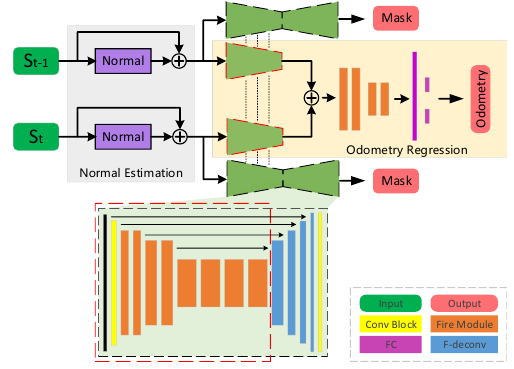
Figure 2. Network architecture of feature extraction layers (red dashed line) and mask prediction layers (black dashed line) . Our network takes two consecutive lidar scans as input and infers the relative 6-DoF